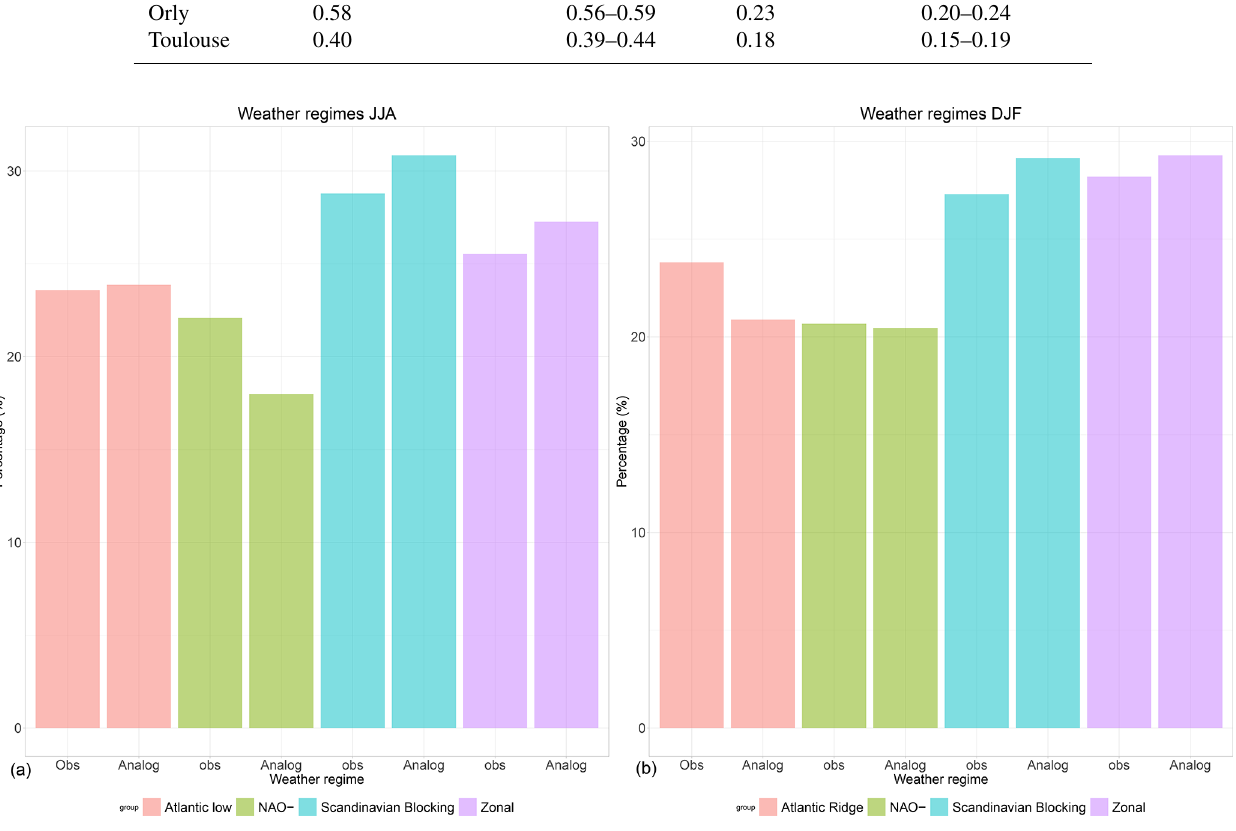
Figure 5. Percentage of each weather regime for observations dates (Obs) and the most frequent weather regime from SWG simulations between t 0 and t 0 + T = 5d (Analog) over the period from 1948 to 2019 for summer (JJA: a ) and winter (DJF: b ). The percentage of weather regime is the same in Obs and